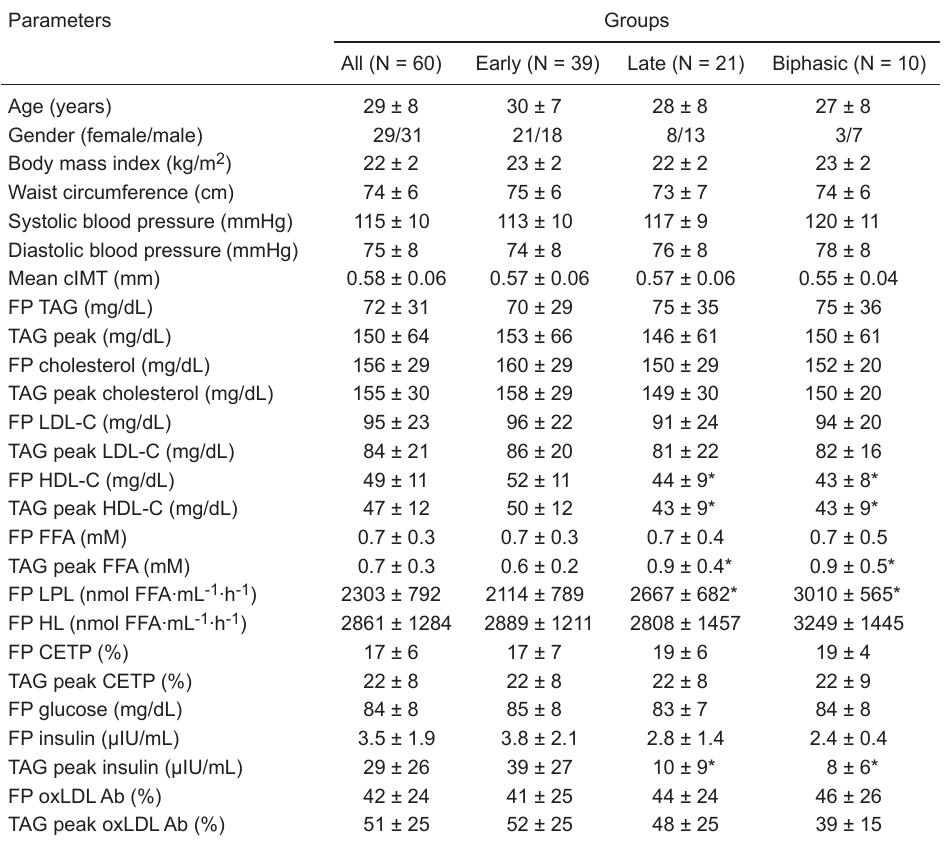
Table 1. Anthropometric and biochemical characteristics of the participants during the fasting and postalimentary periods.